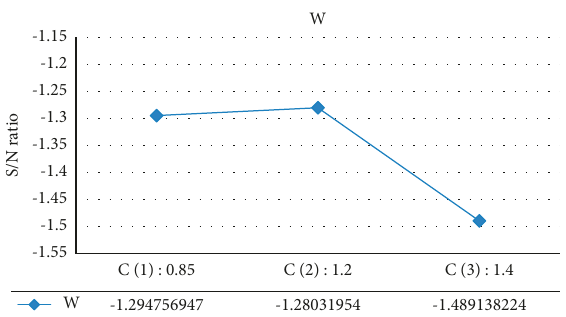
Figure 7: Graph of average S / N ratio for each level of factor W of PSO algorithm in model solution.